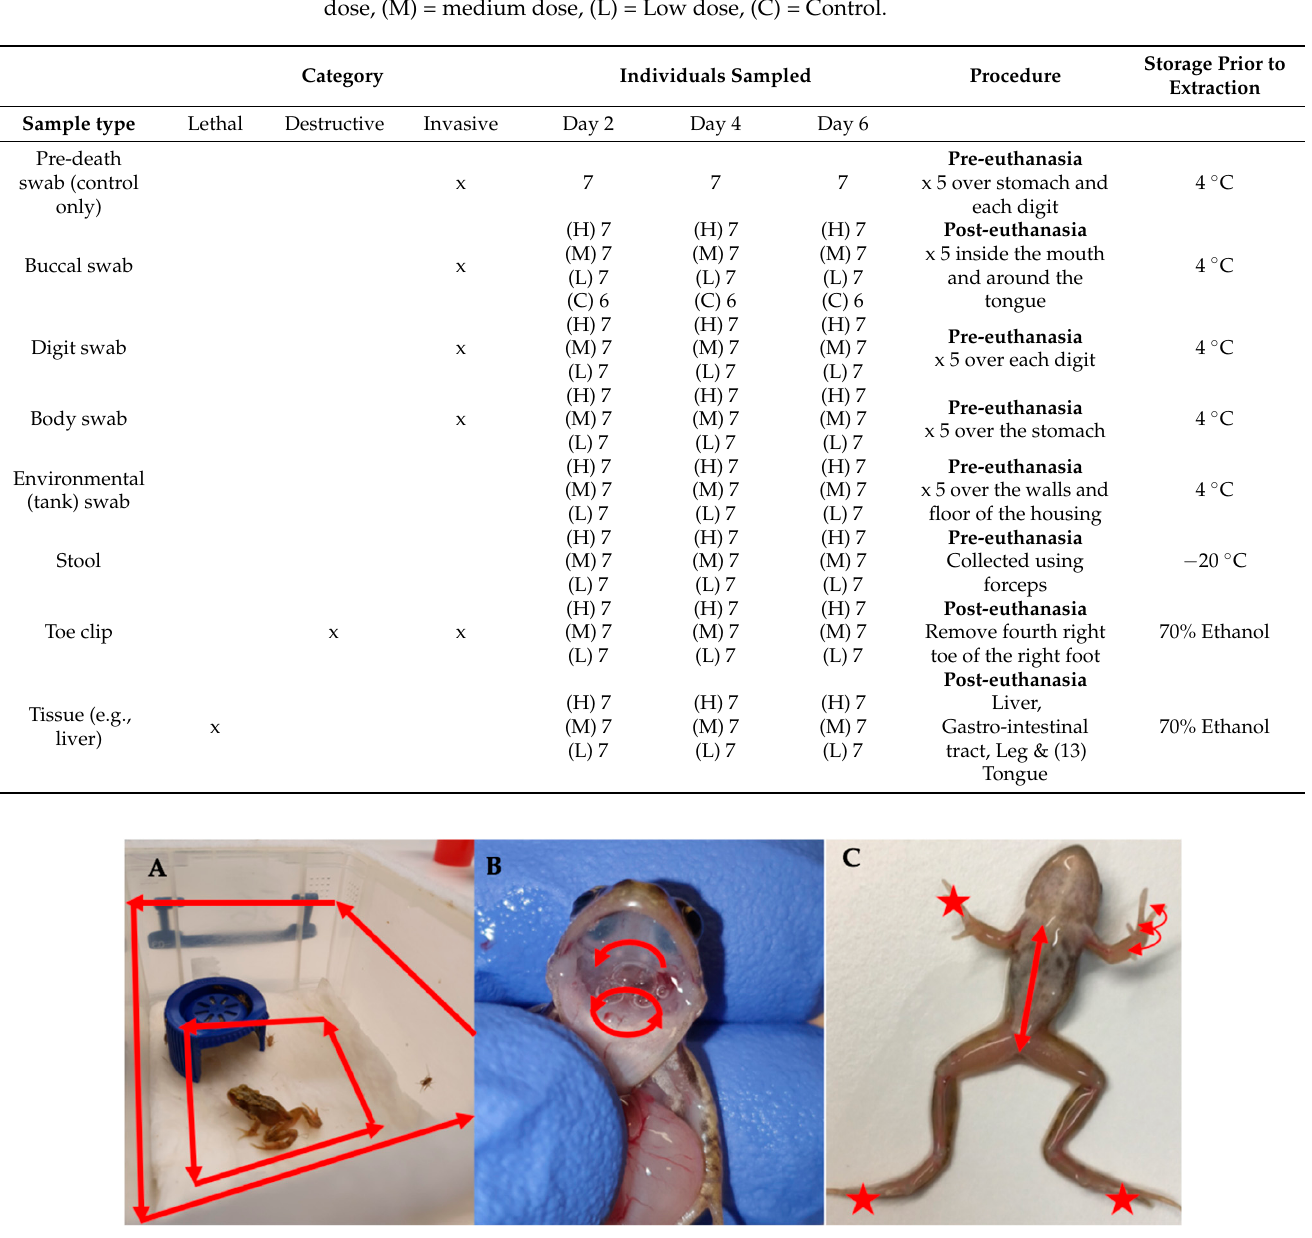
Table 1. Sampling techniques undertaken on R. temporaria throughout the experiment. (H) = high